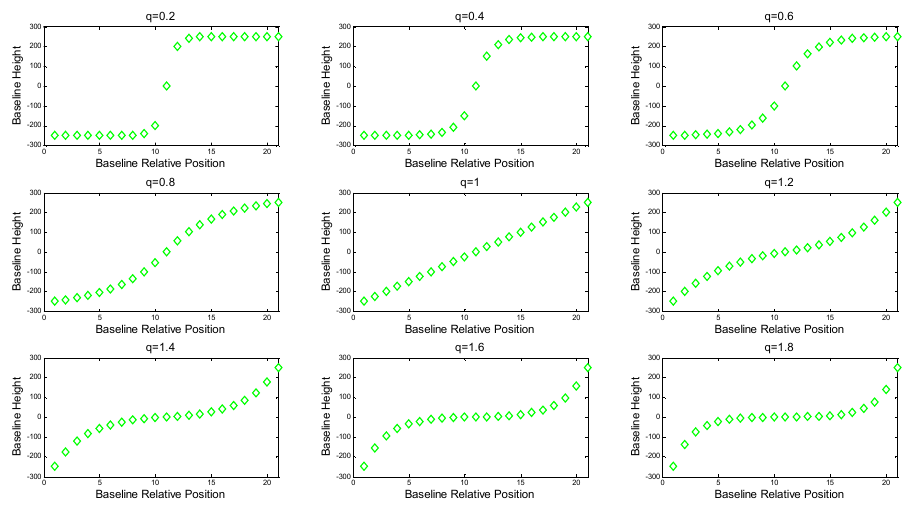
Figure 3. The baseline distribution with changing q (take MN = 21 as an example).